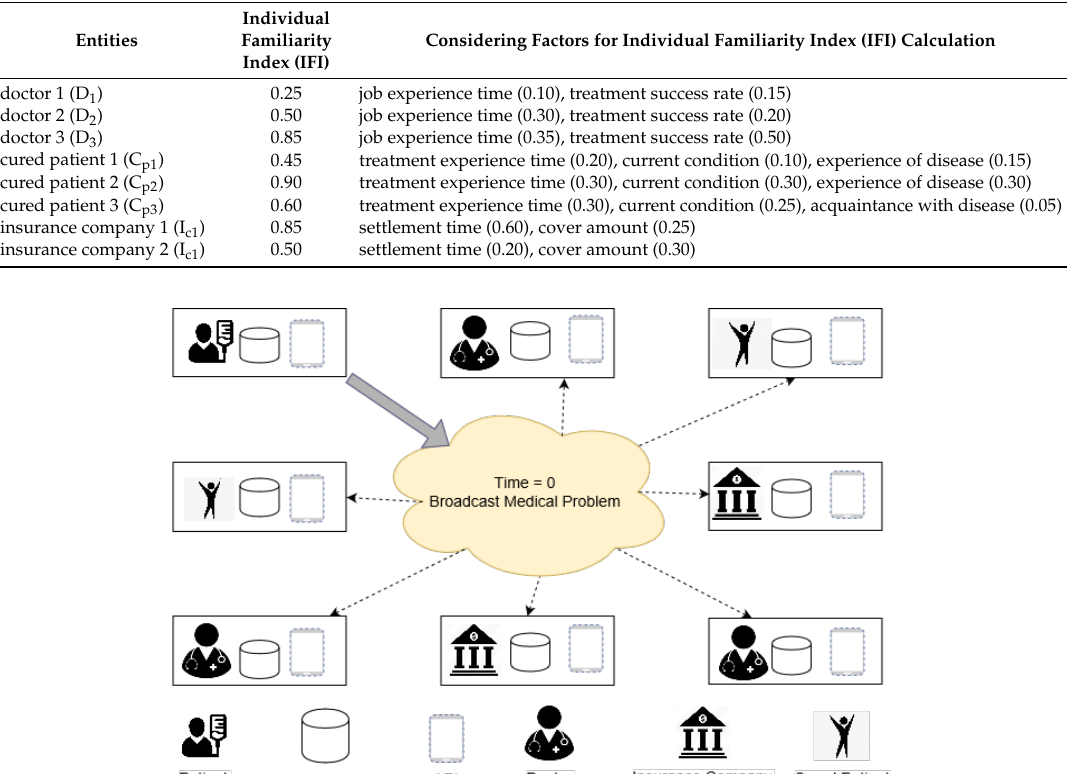
Figure 10. At time 2: Finalize the individual decision and consensus gathering from entities. Figure 11. At time 3: Information storing in local and blockchain (new block created) databases.